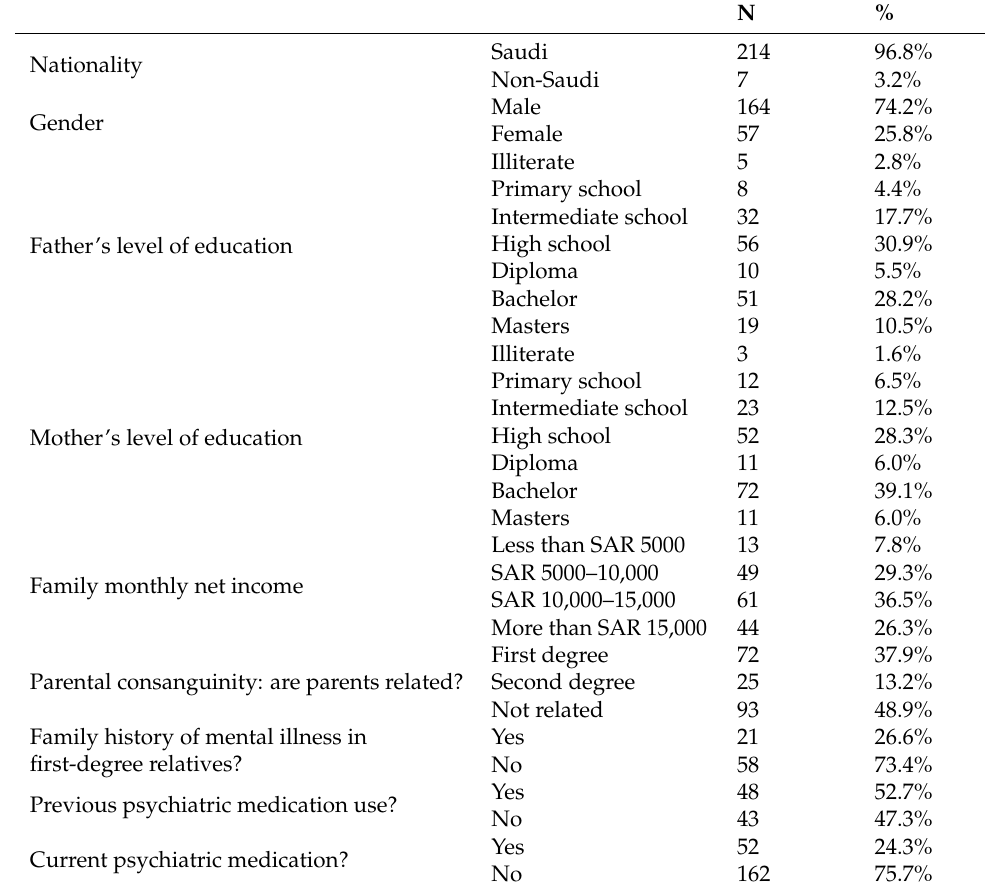
Table 1. Sociodemographic data of participants.